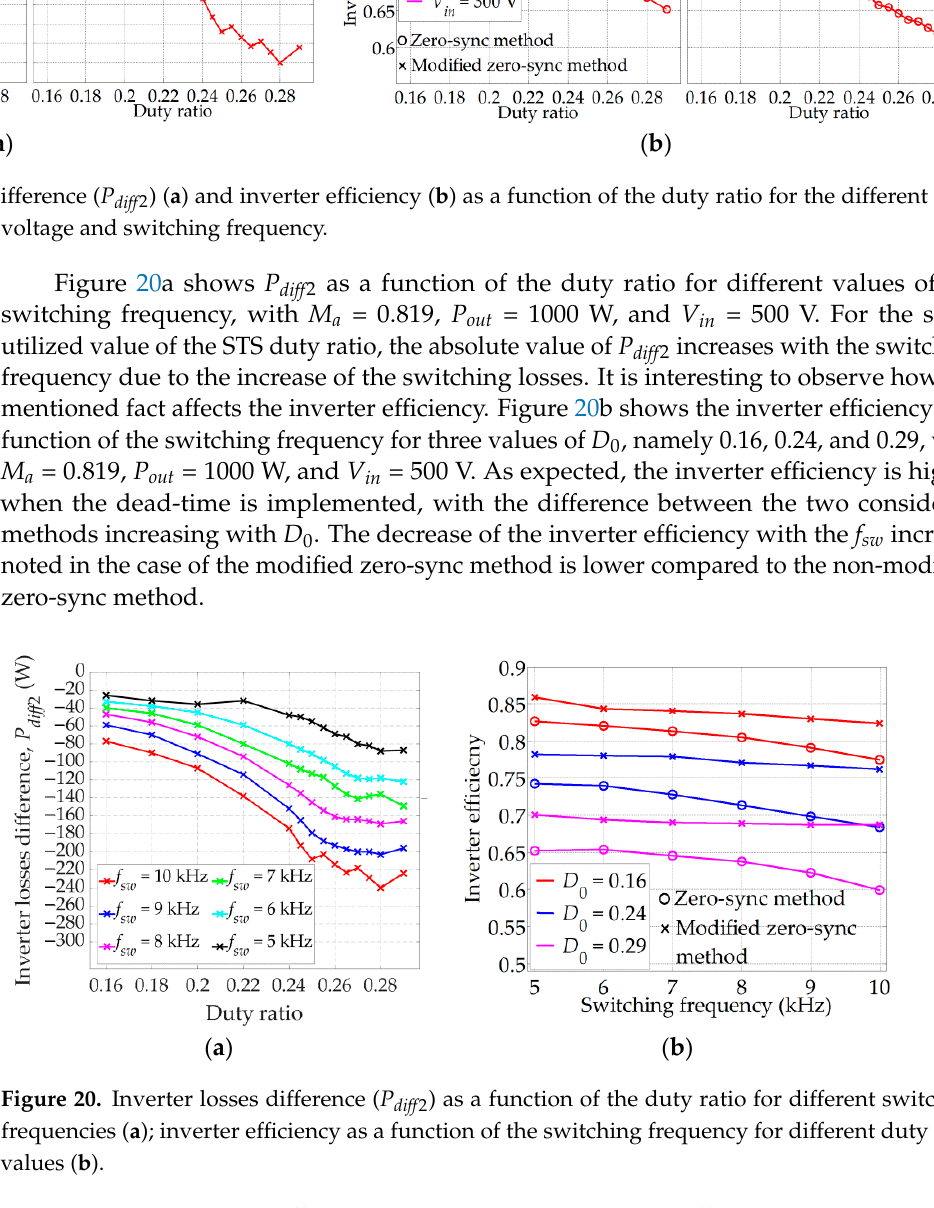
Figure 18. Inverter losses difference ( P diff 2 ) ( a ) and inverter efficiency ( b ) as a function of the duty ratio for the different values of the load power and switching frequency.